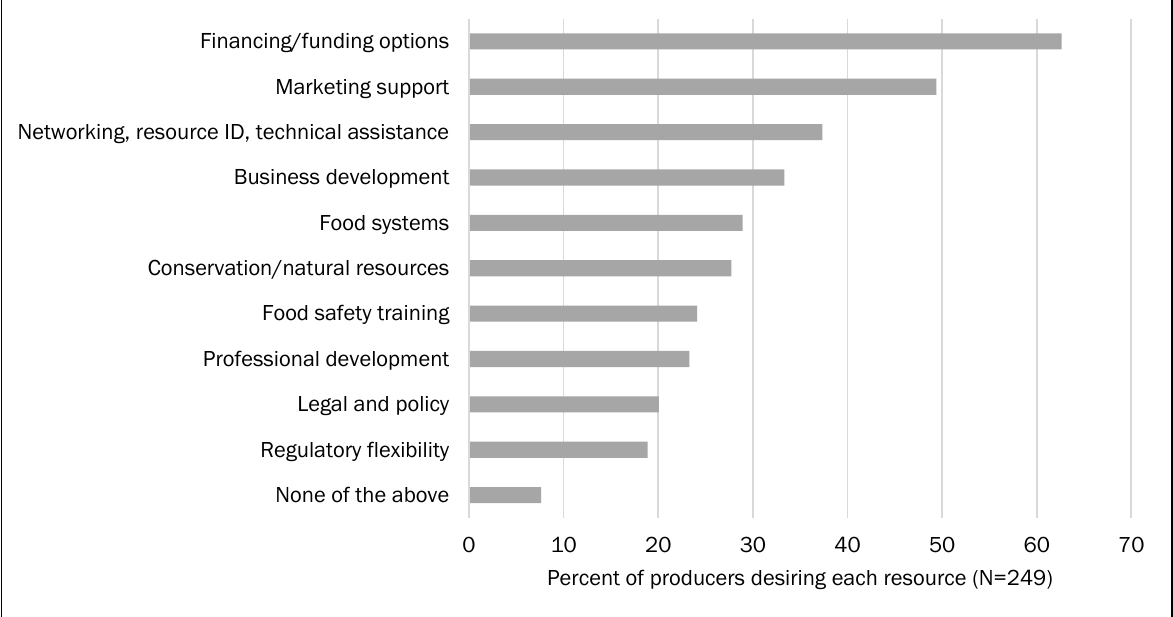
Figure 2. Desired Resources by Producers to Help Their Products Reach Their Target Market or Community